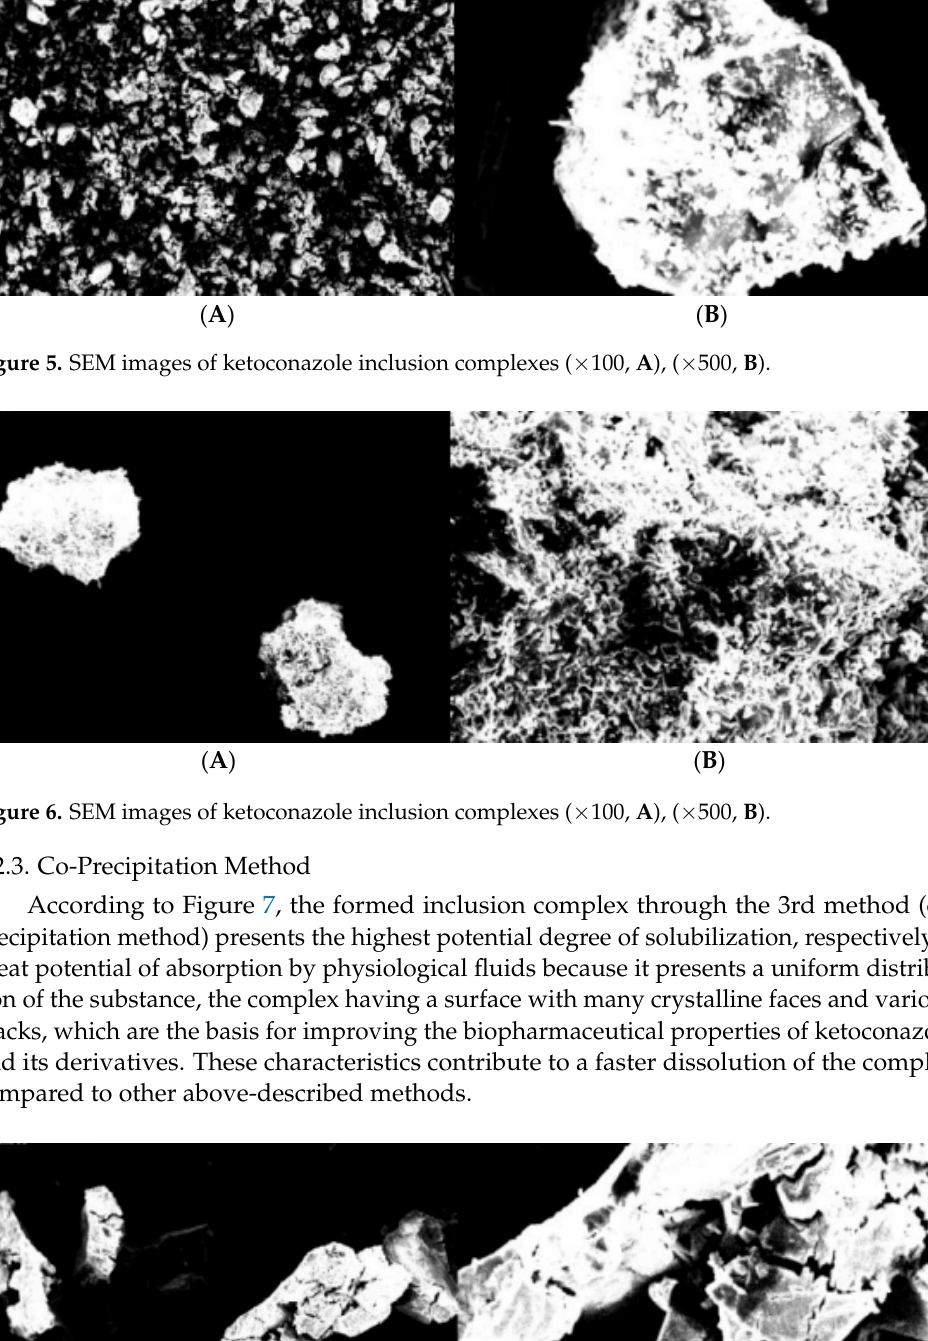
Figure 5. SEM images of ketoconazole inclusion complexes (×100, A ), (×500, B ).